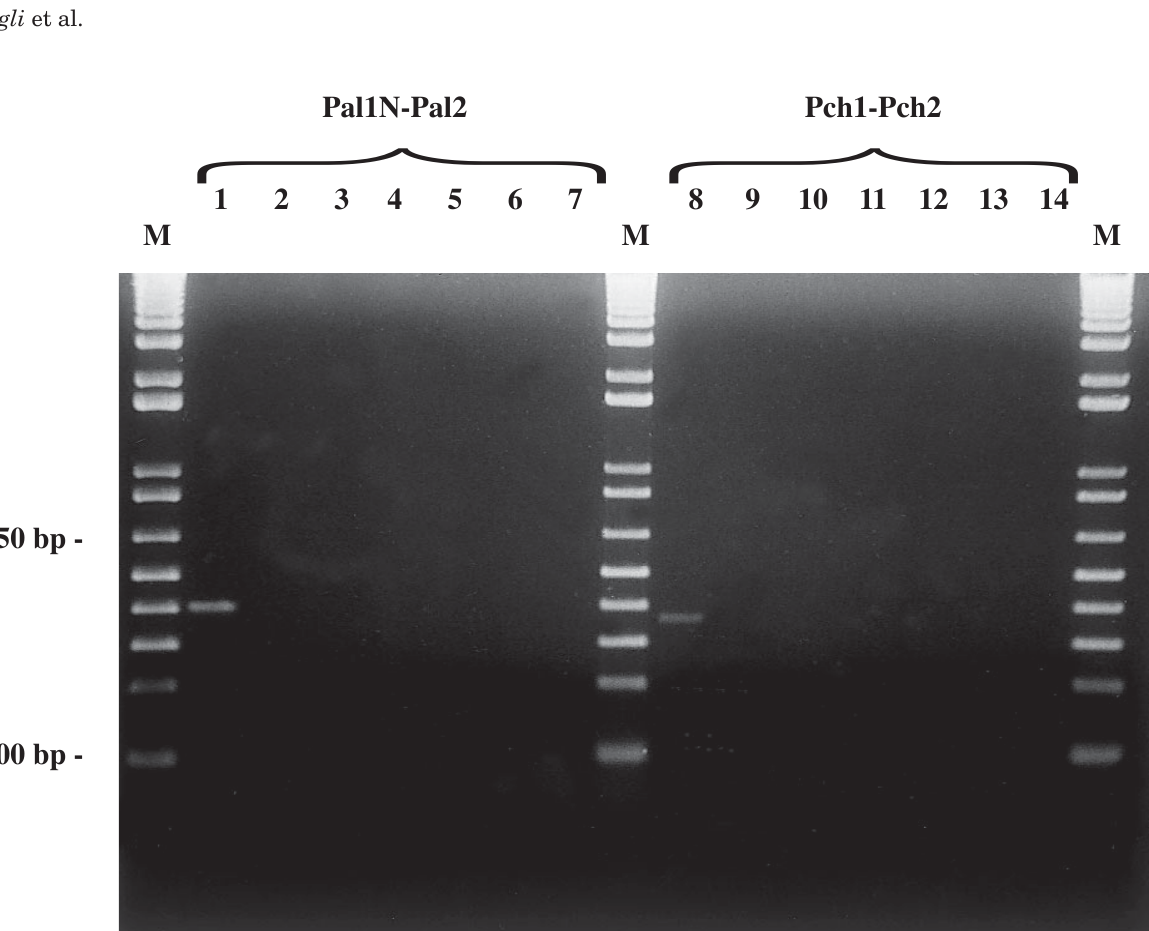
Fig. 5. Gel electrophoresis of the PCR products obtained with primer pairs Pal1N-Pal2 (lanes 1-7) and Pch1-Pch2 (lanes 8-14), using as template 10 ng of fungal or grapevine DNA. Lane 1, P. aleophilum 157; lane 8, P. chlamydospo- rum 56 DNA; lanes 2 and 9, grapevine DNA; lanes 3 and 10, Botryosphaeria obtusa ; lanes 4 and 11, Eutypa lata ; lanes 5 and 12, Fomitiporia punctata ; lanes 6 and 13, Stereum hirsutum ; lanes 7 and 14, negative control with distilled sterile water; lanes M, 1Kb Plus DNA Ladder (Gibco-BRL, Life Technologies). Pch , respectively. No amplification was